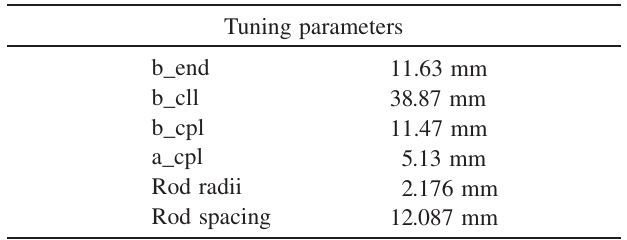
TABLE II. Tuning parameters for PBG structure. Final design values for Fig.